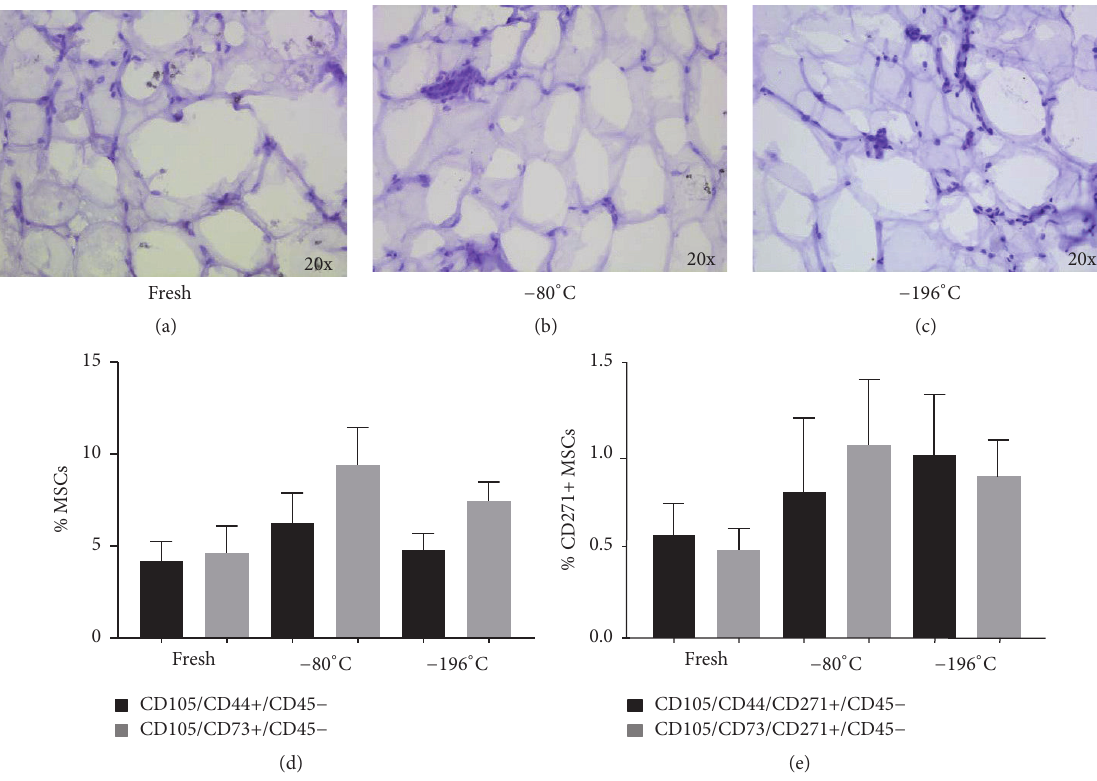
Figure 6: Cryopreservation at − 80 ∘ C and − 196 ∘ C maintained morphology of adipose tissue and the content of ATD-MSCs. The morphology of cryopreserved adipose tissue at − 80 ∘ C and − 196 ∘ C was maintained, without evidence of tissue degeneration or necrosis, comparable to the fresh sample (a–c). The percentage of CD105, CD44, and CD73+ ATD-MSCs and the CD271+ subpopulation was comparable to fresh samples and also between the two temperatures (d,